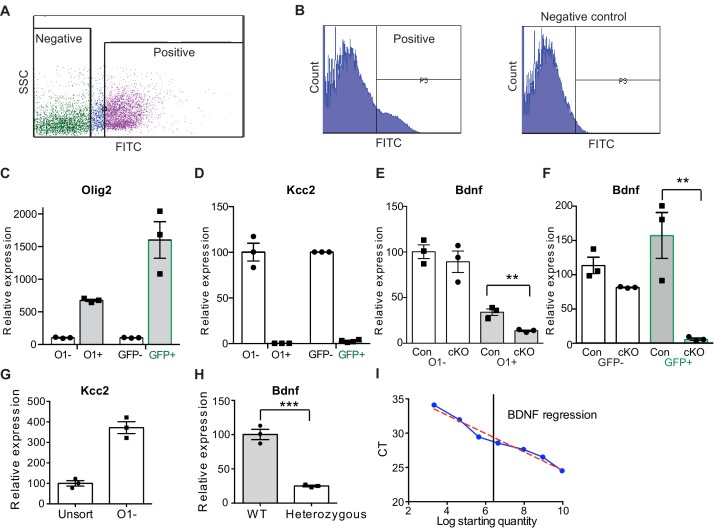
Specific reduction of BDNF in OLs in Cnpcre: Bdnffl/fl mice.(A–B) Fluorescent activated cell sorting (FACS) revealed a distinct positive population based on scatter properties and fluorescence (A). SSC = side scatter. Histogram profiles were used to select the positive fraction. Example of histograms of isolated cells from a Cnpcre: GCAMP6f-GFP+ mouse versus a Cnpcre: GCaMP6f-GFP- as a negative control (B). (C) Verification of the isolated cells using qPCR. To isolate OLs, cells were sorted using an antibody for O1, an OL marker, or GCaMP6f-GFP (GFP). The O1+ or GFP+ cells demonstrated an enrichment of Olig2 mRNA quantified by qPCR. (D) The neuronal marker, Kcc2, was not detected from O1+ or GFP+ population. This data indicates that O1+ or GFP+ cells are Olig2+ and Kcc2- OLs. (E–F) Relative expression of Bdnf: All values are relative to the negartive control (O1- or GFP- population). Bdnf mRNA levels did not differ in the cKO O1- or GFP-fraction compared to the negative fraction. cKO O1+ fraction was significantly lower than the control O1+ populations (85 ± 2% reduction cKO O1+, t-test, **p<0.01, (E). cKO GFP+ fraction was significantly lower than the control GFP+ population (97 ± 3% reduction cKO GFP+ vs Control GFP+, t-test, **p<0.01, (F). This indicates a specific reduction of Bdnf in OLs from cKO. (G) Relative expression of Kcc2. There is no loss of neurons expressing Kcc2 in sorted cells from either O1- cells (372 ± 50, n = 3 mice) compared to unsorted population (100 ± 23, n = 3 mice). (H) To test the quality of Bdnf primer, we tested BDNF heterozygous mice. Bdnf is significantly reduced in heterozygous mice (mean ± s.e.m. = 25 ± 2 vs 100 ± 13, t-test, p=0.0006, n = 3 mice/genotype) indicating the Bdnf primer is amplifying Bdnf specifically. (I) The Bdnf primer shows linear amplification with low input RNA (r2 = 0.97, linear regression, p<0.0001). 100 ng was utilized for each comparison (black line). Therefore, even with low input and CT values > 27, the Bdnf probe can detect changes in input levels. Data in graph is shown as mean ± s.e.m. three technical replicates/gene from n = 3 mice/genotype were analyzed.